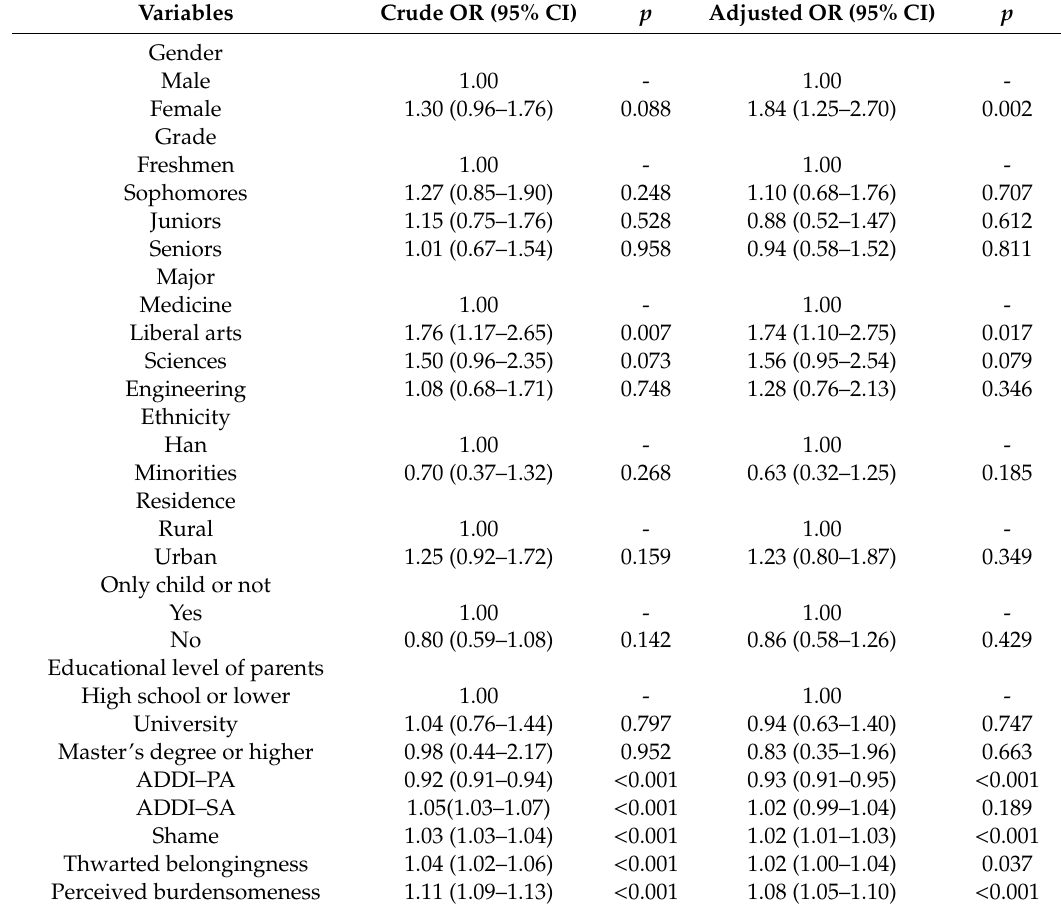
Table 3. Risk of suicidal ideation among undergraduate students by logistic